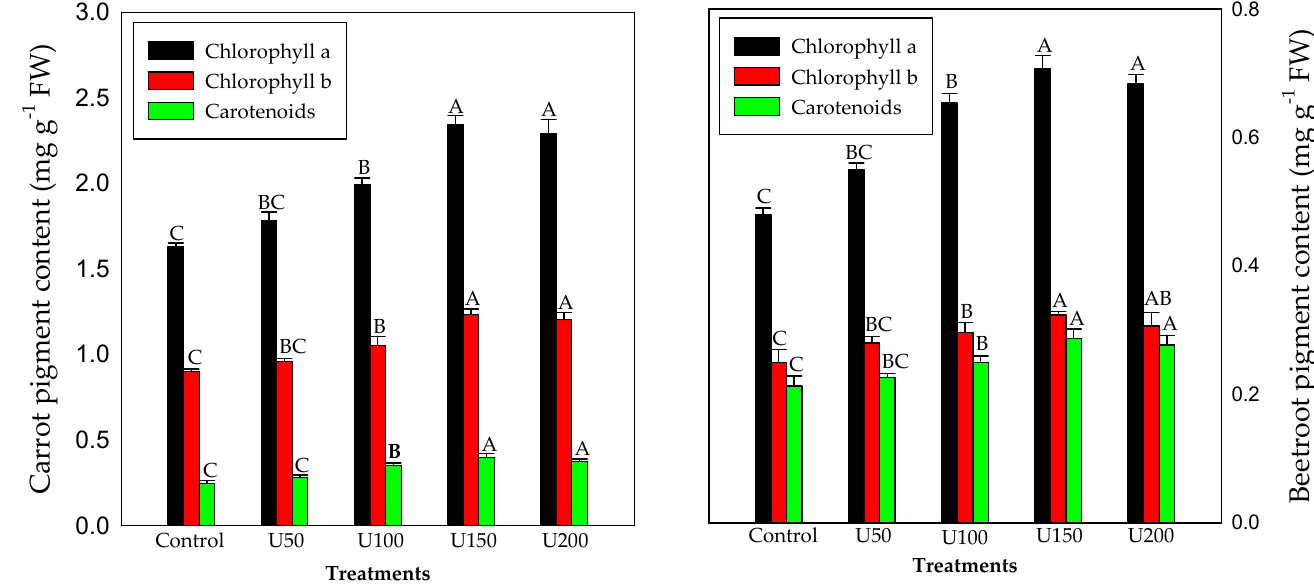
Agriculture 2021 , 11 , x FOR PEER REVIEW Figure 3. Scanning electron micrograph of carrot and beetroot leaves, showing the impact of different N levels on the stomatal aperture of carrot at control and U150 and stomatal aperture of beetroot at control and U150.